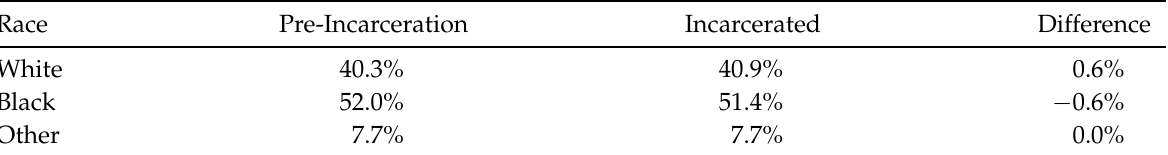
Table 3: Racial classification of ever-incarcerated respondents for the year immediately before and during the first year of incarceration . From the National Longitudinal Survey of Youth,